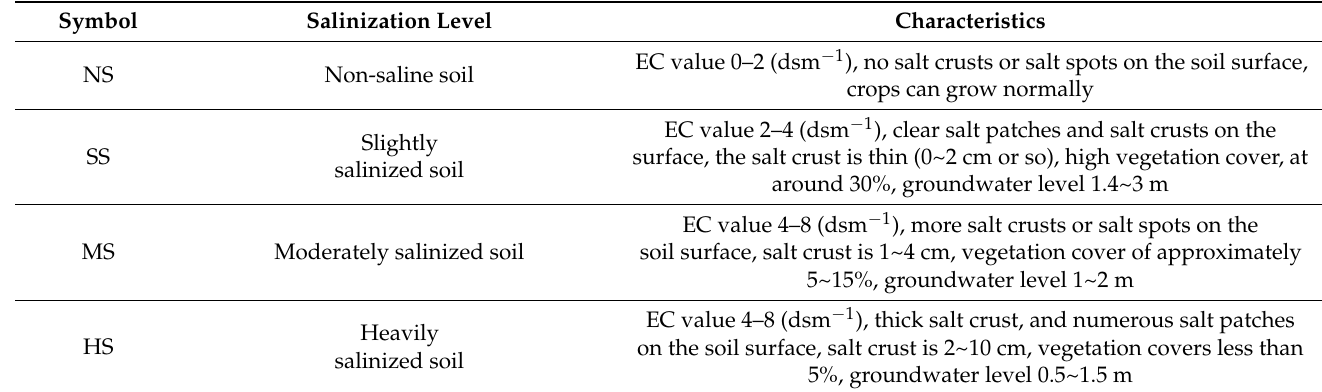
Table 2. Soil salinity